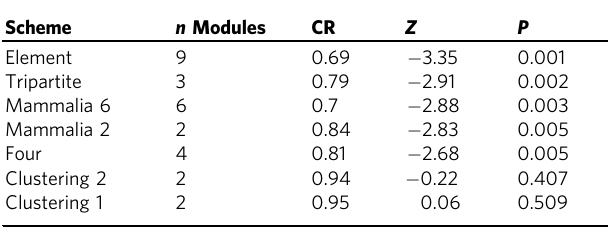
Table 2 Results of phylogenetic modularity tests using the covariance ratio